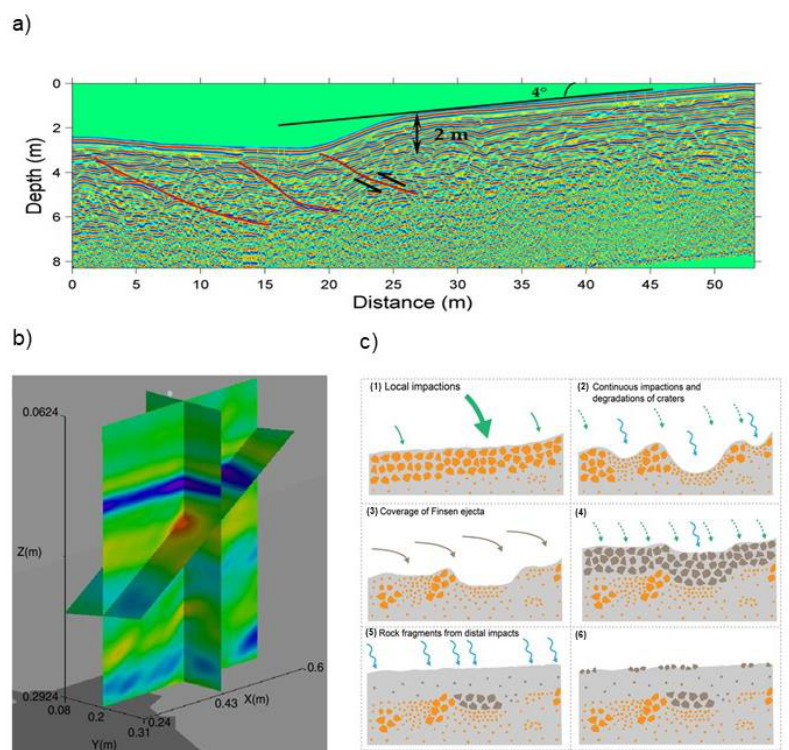
Figure 4. Different survey modes for GPR. ( a ) Surface GPR: FO, CMP, and WARR measurements; ( b ) Borehole GPR: ZOP, MOP, and VRP measurements; ( c ) Off-ground GPR; ( d ) a field picture showed the off-ground system mounted on a survey vehicle [17].